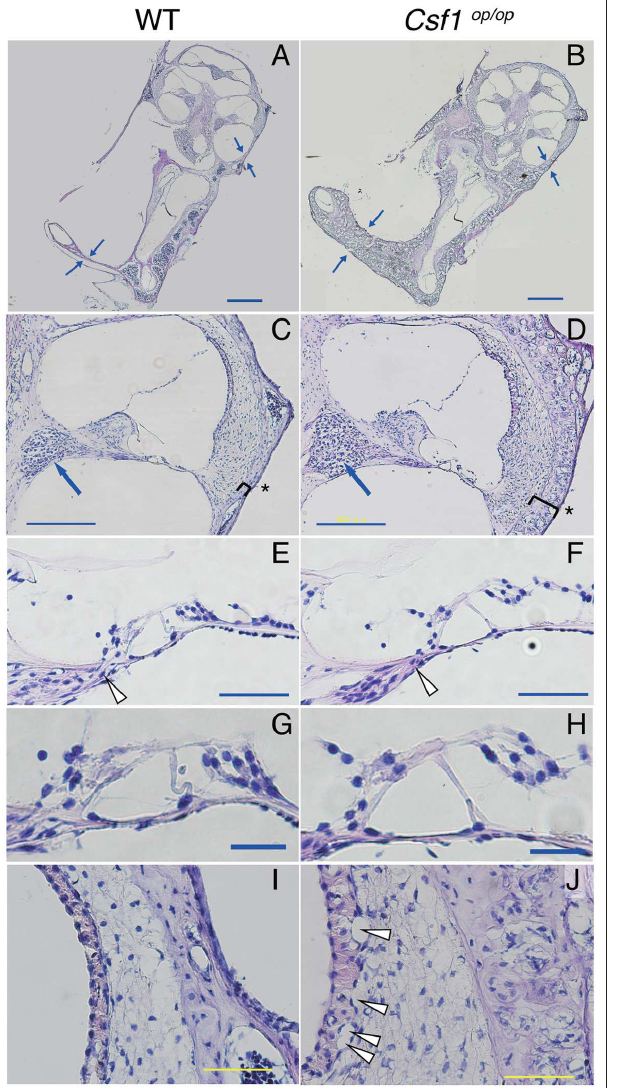
basal turn, whereas that in Csf1 op / op mice was 76.1 ± 2.3 µ m.